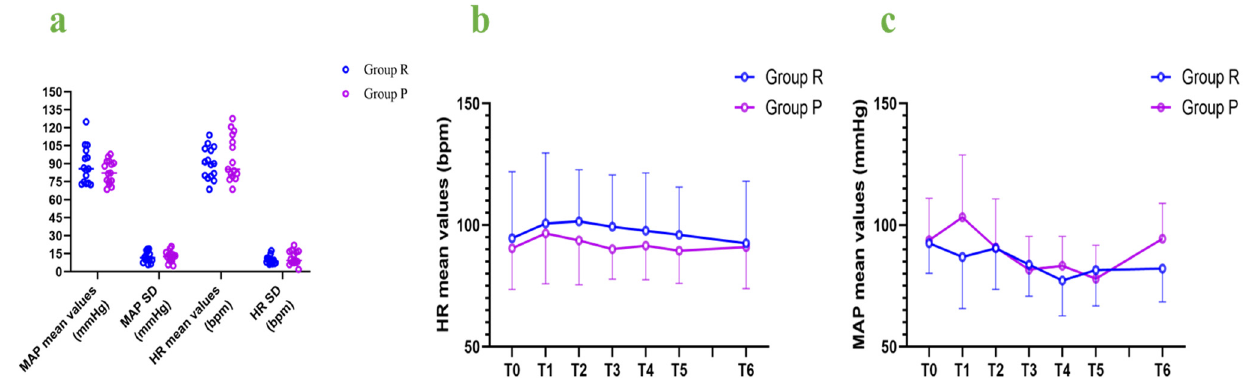
Figure 4. Hemodynamic fluctuations: ( a ) MAP mean values and SD, as well as HR mean values and SD; ( b ) HR mean values at different time points; ( c ) MAP mean values at different time points. MAP: mean arterial pressure; HR: heart rate; SD: standard deviation; bpm: beats per minute; T0: baseline; T1: intubation; T2: 5 min after intubation; T3: 10 min after intubation; T4: 15 min after intubation; T5: 20 min after intubation; T6: extubation. MAP: mean arterial pressure; SD: standard deviation.